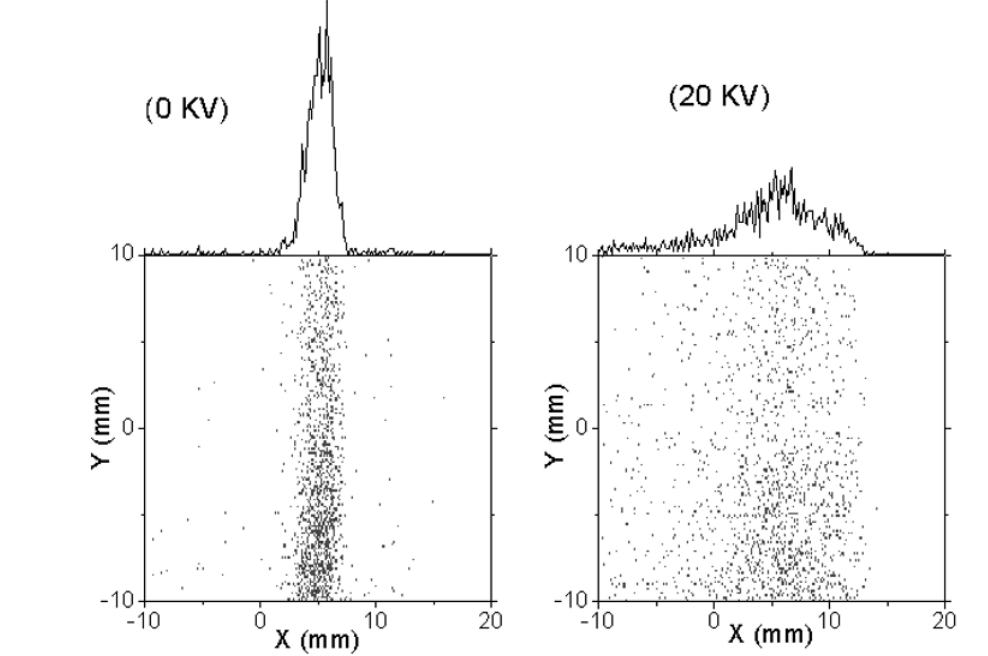
Figure 2. Experimental beam profiles and images obtained respectively for F = 0 (0 KV) and F = 8.8×10 6 V m -1 (20 KV) recorded by the sensitive detector. Table 1. Relative energies, rotational constants, and calculated electric dipole of PFAN in planar and non planar geometries obtained at MP2 level of theory, basis set 6-311++G**. The calculations were performed with Gaussian 98. Rotational constants (cm -1